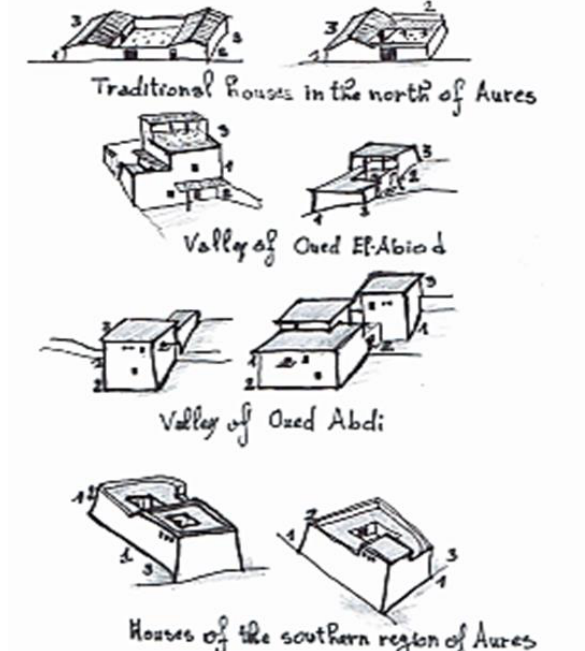
Figure 7. Details of a Berber house types. Samia AJALI